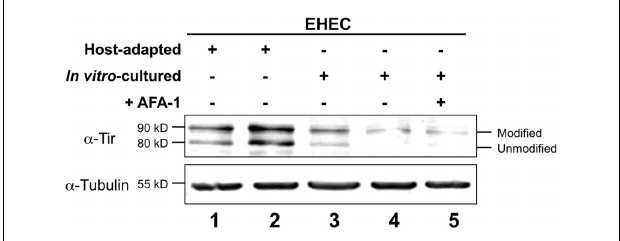
FIGURE 4 |Translocated intimin receptor translocation is enhanced upon host adaptation. Mammalian cell monolayers were infected for 6h with equivalent numbers of host-adapted EHEC isolated from the intestine of two different gnotobiotic piglets (lanes 1–2) or in vitro -cultured EHEC strains alone (lanes 3–4) or in vitro -cultured EHEC harboring a plasmid encoding AFA-1 (lane 5). Lysates of infected monolayers were resolved by SDS-PAGE and immunoblotted forTir and tubulin.Western blots from a representative experiment are shown.The migration of unmodified and modifiedTir is indicated (right), and numbers on the left indicate apparent molecular mass.